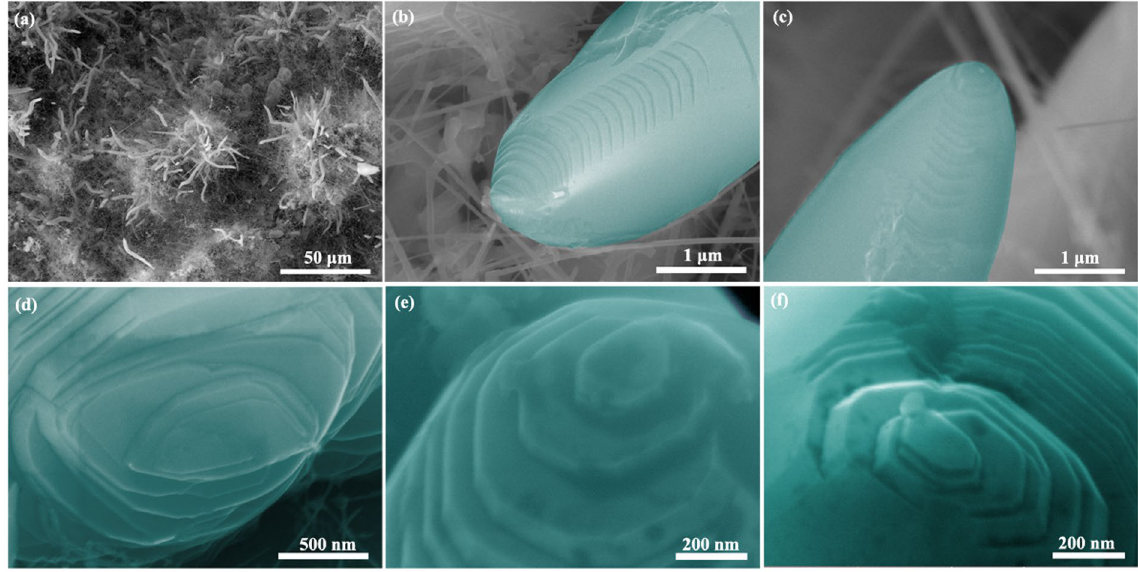
Figure 1. ( a ) SEM surface image of the as-synthesized α -Al 2 O 3 nanowires on the as-prepared SiC-Si-Al 2 O 3 ceramics; ( b ) and ( c ) SEM images of a representative screw dislocation core on the conical tip of α -Al 2 O 3 nanowires; ( d ), ( e ) and ( f ) high-magnification SEM images of the representative screw dislocation core on the tip of α -Al 2 O 3